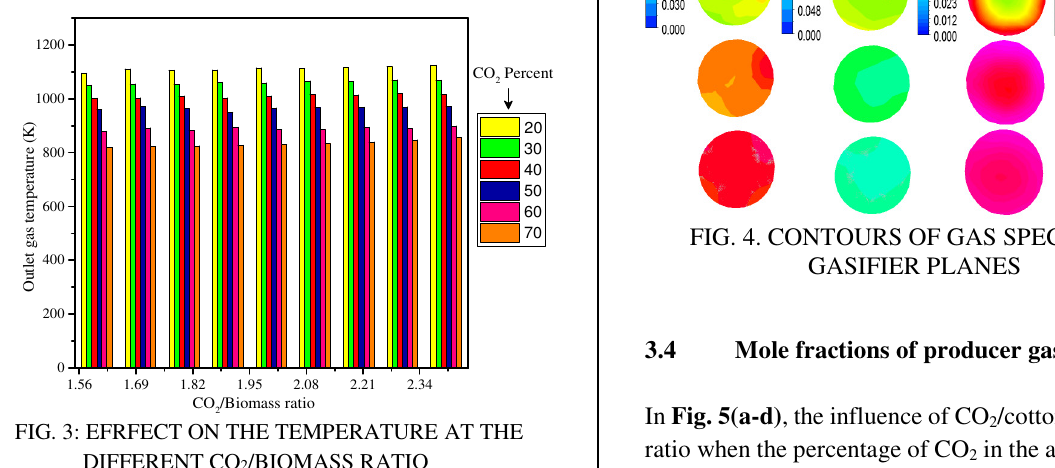
FIG. 3: EFRFECT ON THE TEMPERATURE AT THE DIFFERENT CO 2 /BIOMASS RATIO